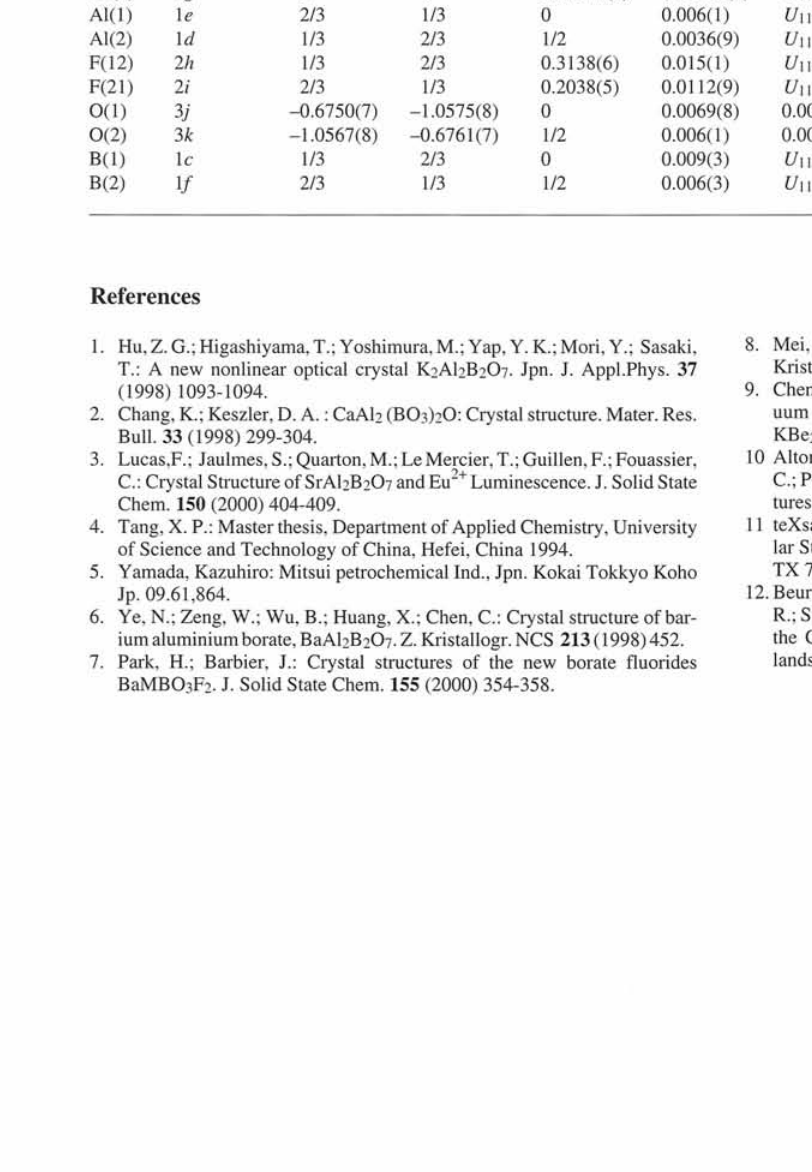
Table 2. Atomic coordinates and displacement parameters (in Â 2 ).